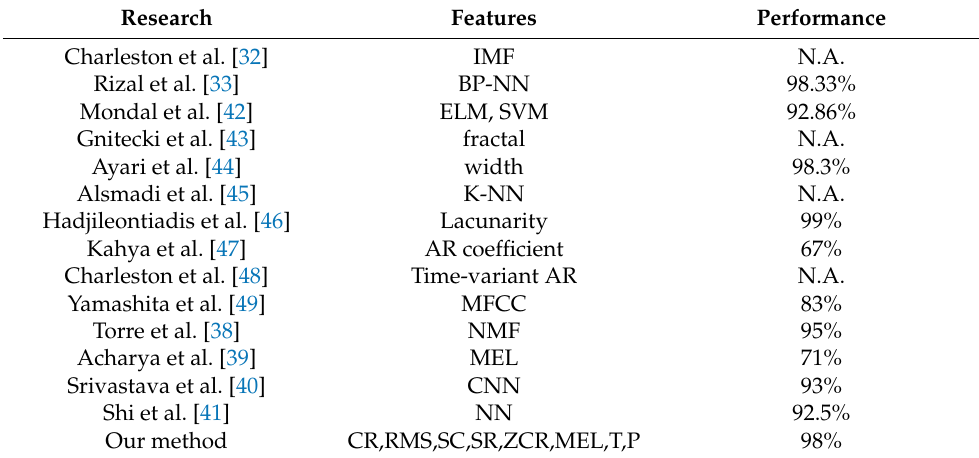
Table 5. State of the art comparison in lung disease classification; (N.A. stands for data not available). Research